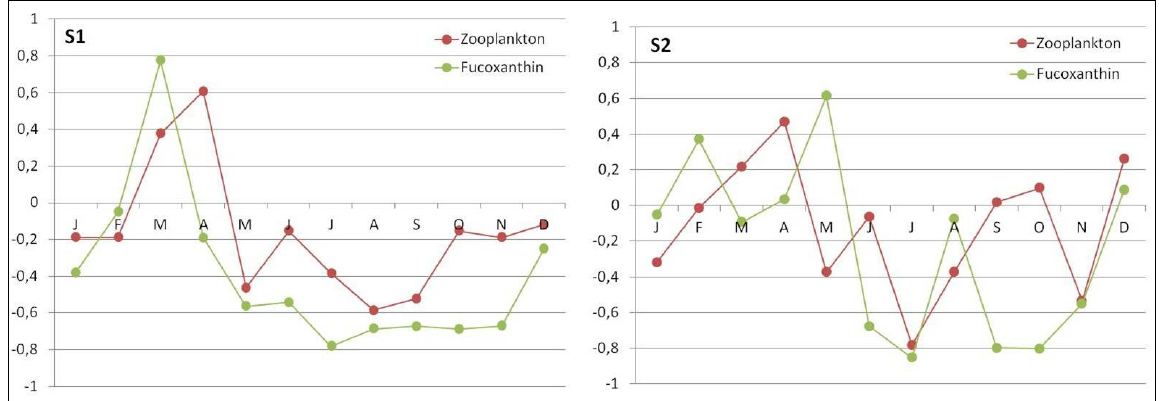
Figure 11. Relative data on zooplanktonic biovolume and fucoxanthin (specific marker pigment of diatoms) in S1 and S2 stations during the annual